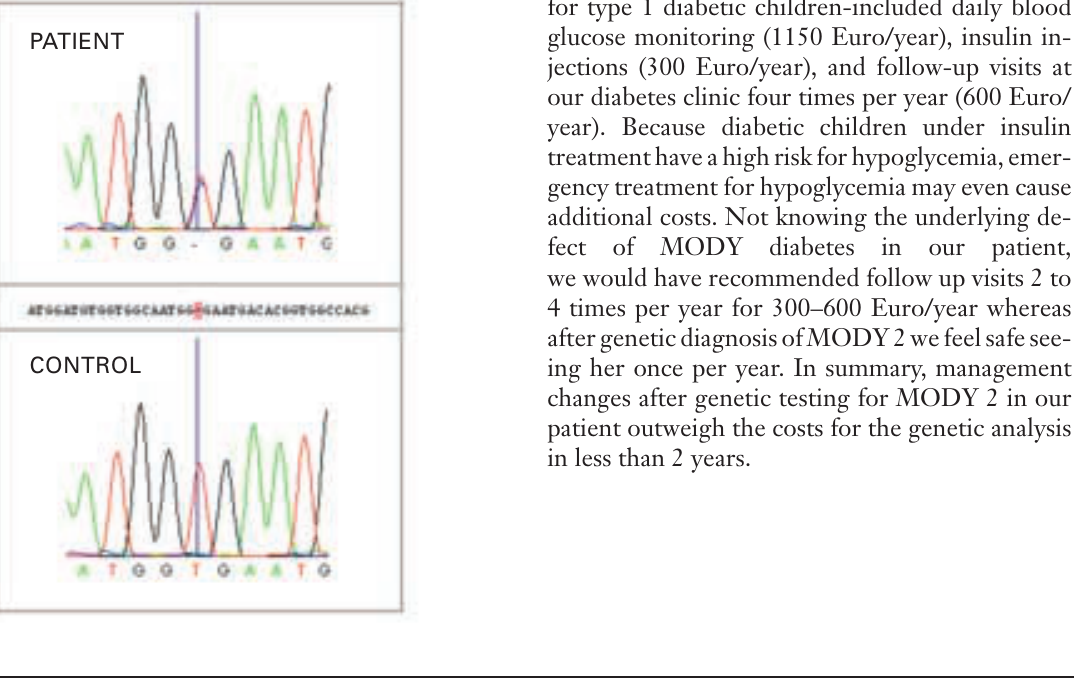
Figure 2 Sequence analysis showing the het- erozygous GTG>GCG mutation in the pa- tient but not the con- trol. This mutation causes the V203A mutation in the